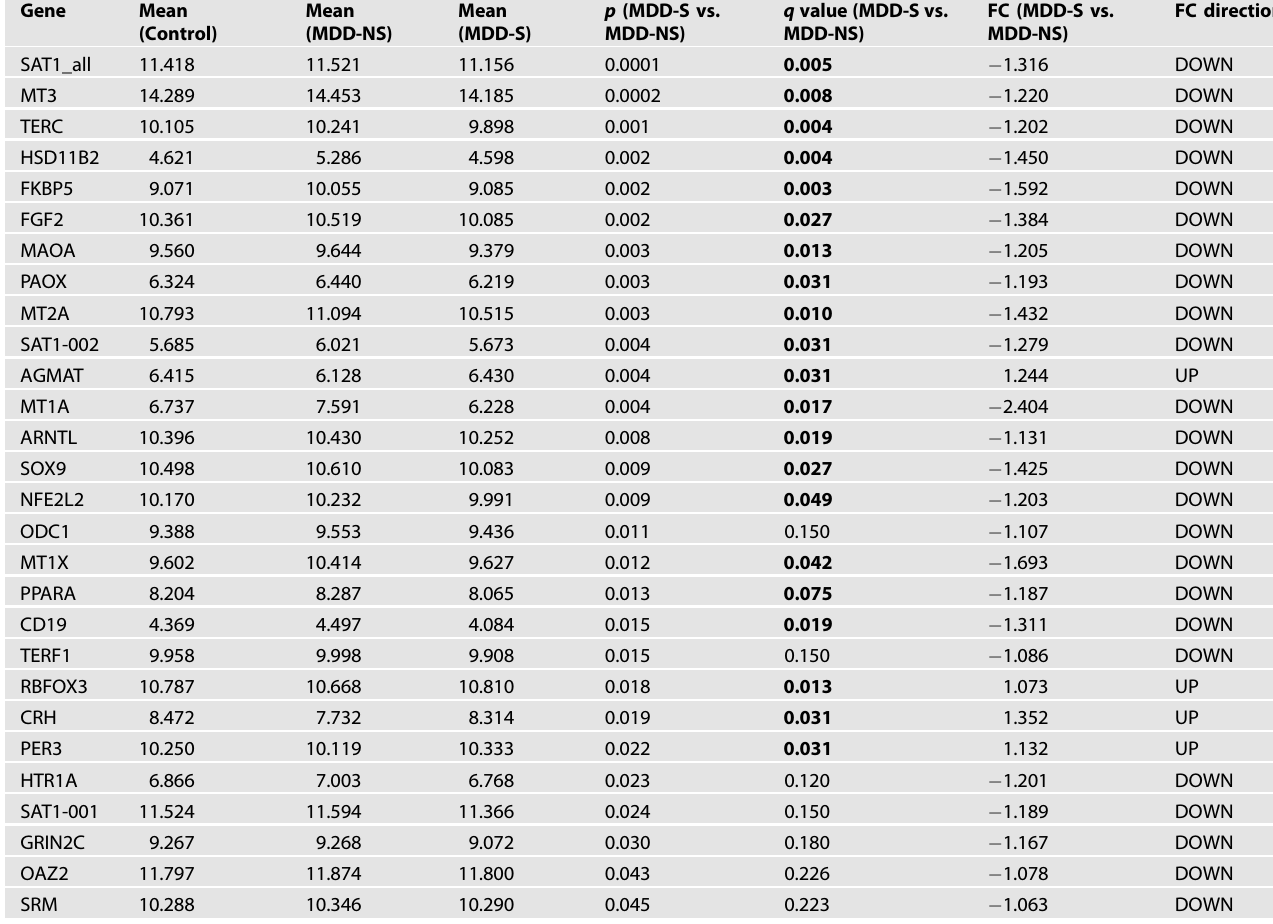
Table 3. Signi fi cantly differentially expressed genes between MDD-S and MDD-NS in the DLPFC ( p ≤ 0.05), corresponding q -value after FDR correction ( q ≤ 0.1 are in bold), and fold change in MDD-S relative to